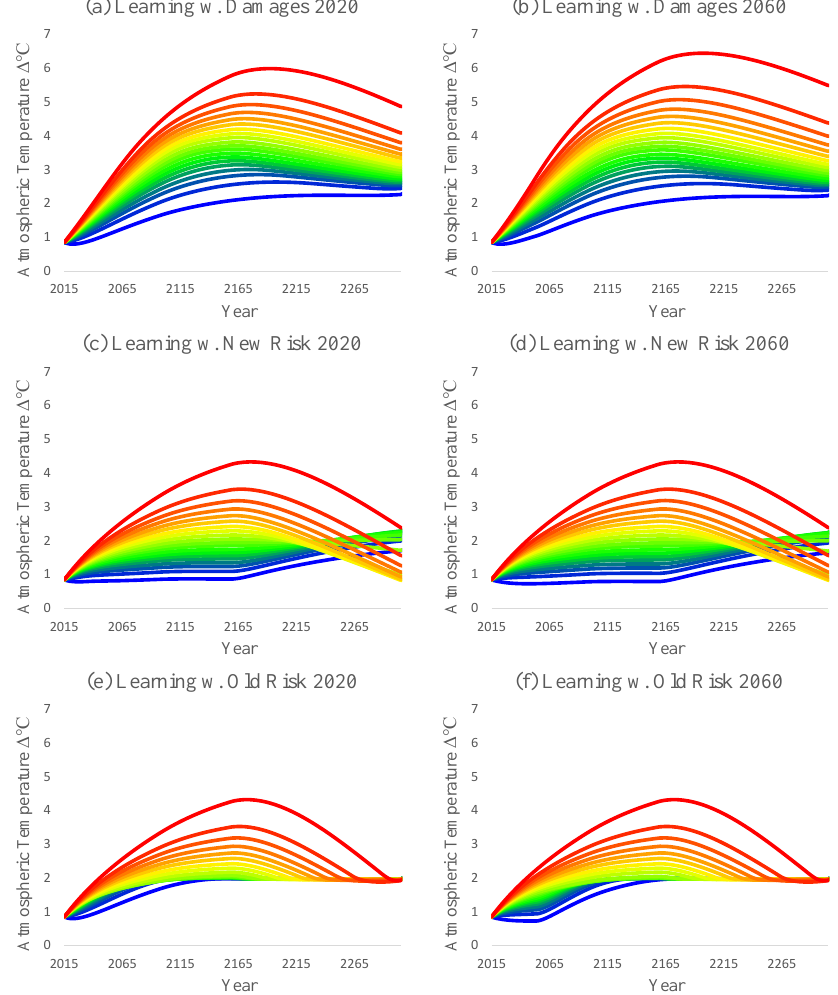
Figure 4. Atmospheric temperature evolution in learning cases using damage function, new risk (New CRA), and old risk (Old CRA) scenarios. The colors show different states of the worlds ranging from dark blue for the lowest climate sensitivity to dark red for the highest climate